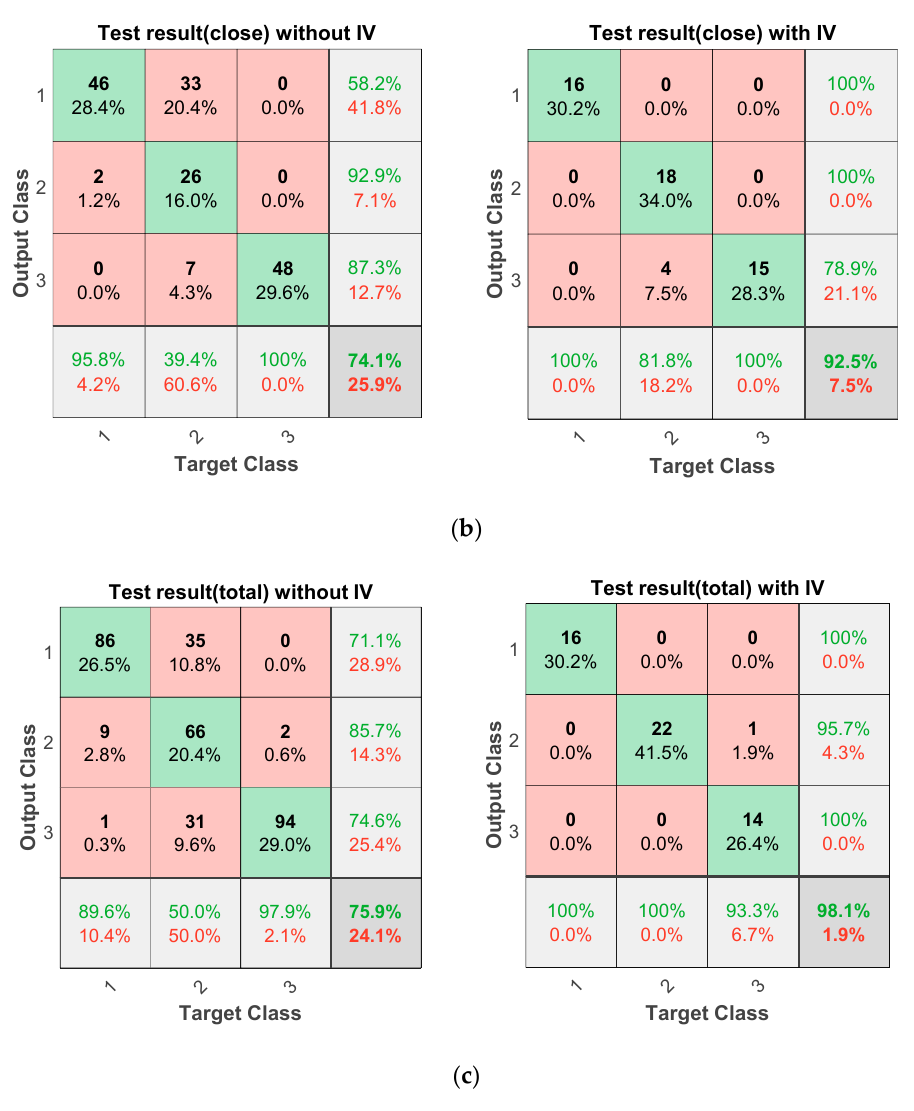
Figure 7. Comparison of fault diagnostic results before and after applying information value: ( a ) open operation; ( b ) close operation; ( c ) open & close operation.